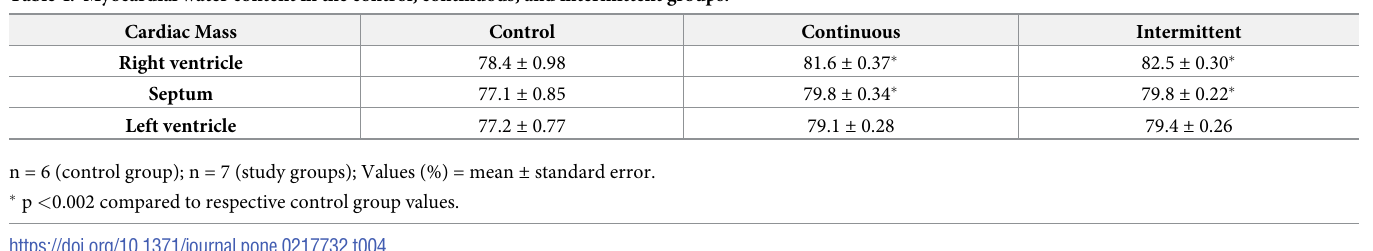
Table 4. Myocardial water content in the control, continuous, and intermittent groups.